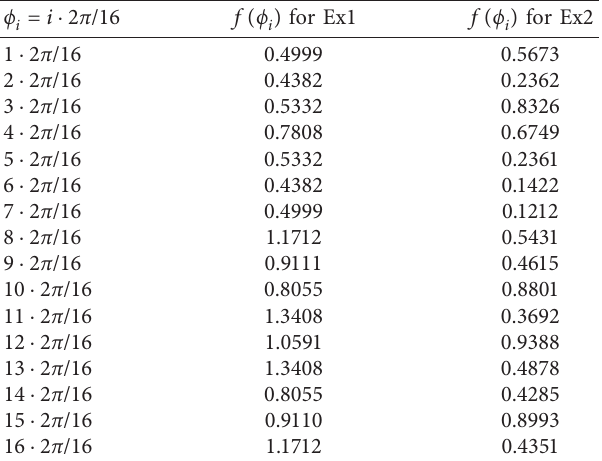
Figure 5: Reconstructed target shape for different iteration loops of the whale optimization algorithm in the first example. Table 2: Values of sampling points ( M � 16) for the true target shape function in the first (Ex1) and second (Ex2) examples.